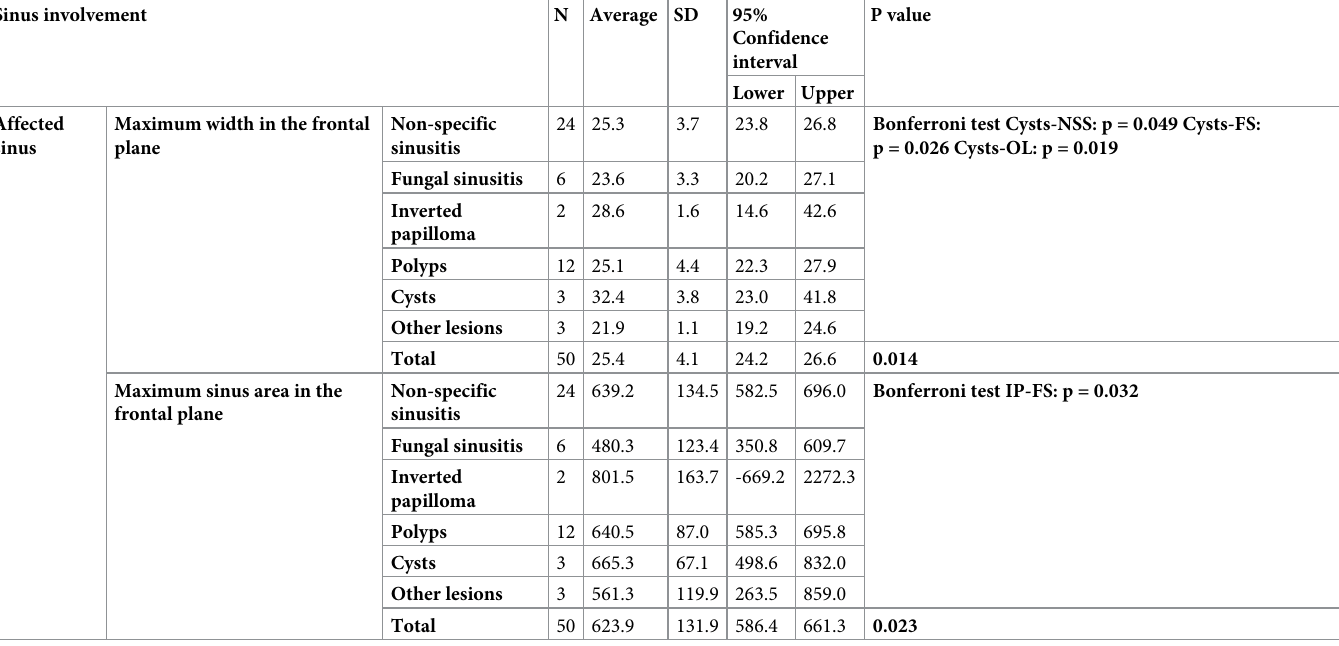
NES = Non-specific sinusitis; FS = fungal sinusitis; OL = other lesions; IP = inverted papilloma. Bonferroni correction has only be applied for the statistically significant values (p <